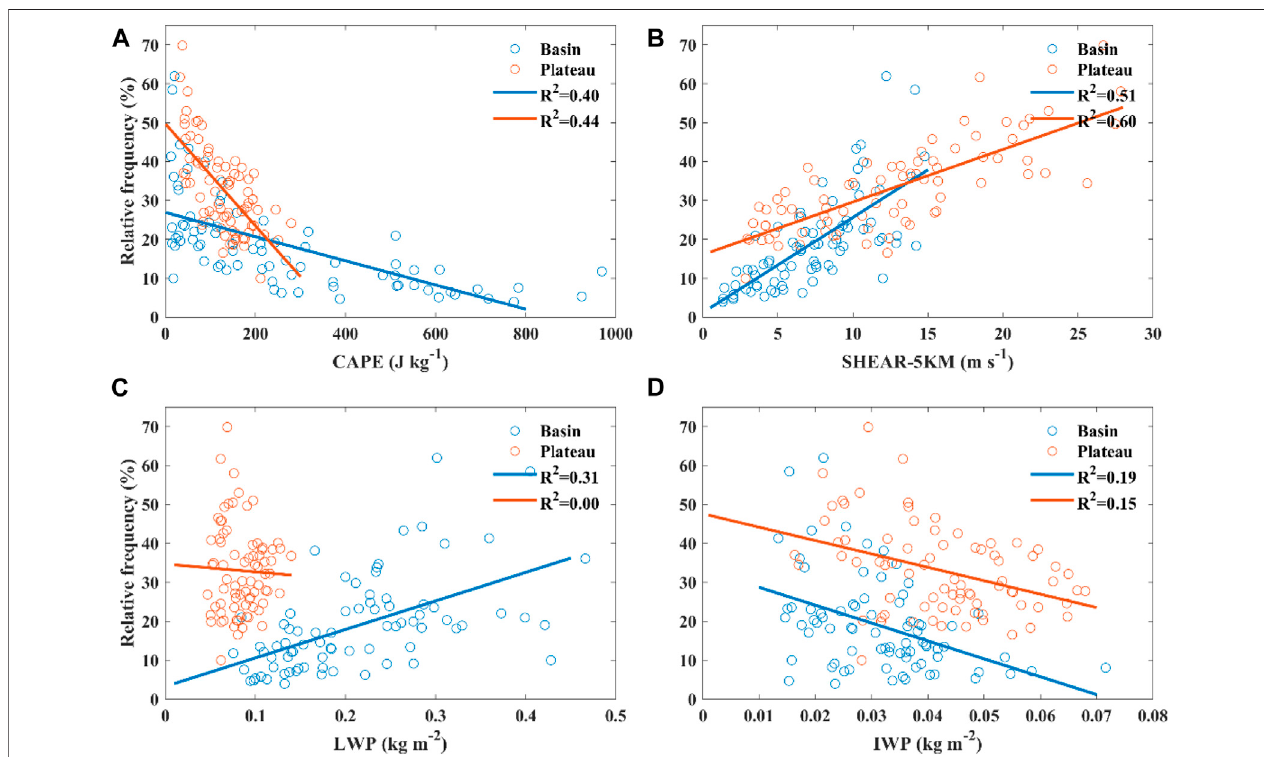
FIGURE 5 | The function of CAPE (A) , SHEAR-5 km (B) , LWP (C) , and IWP (D) with the relative frequency ofpositive CG lightning in the basin and plateau regions during the warm